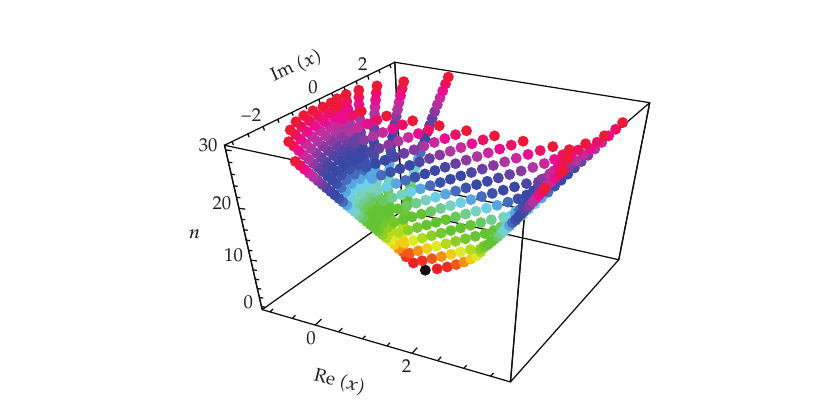
Figure 4: Zeros of B